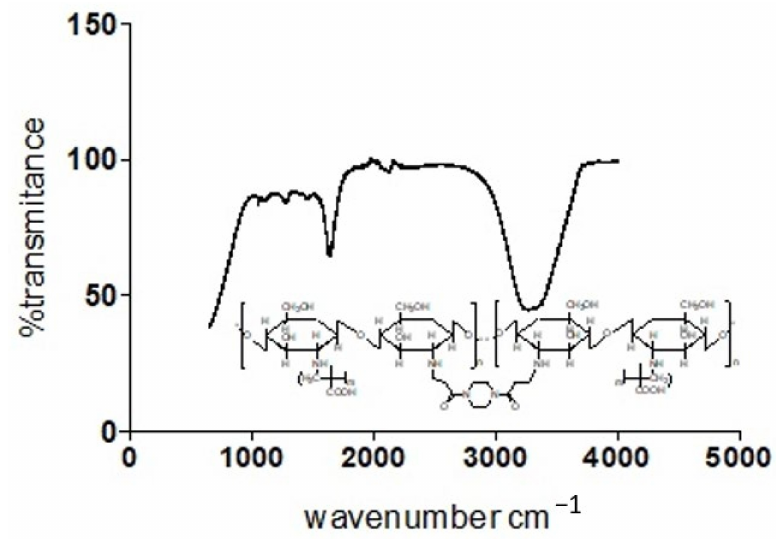
Figure 11. Plot of transmittance against wave number for Chitosan, MAA and